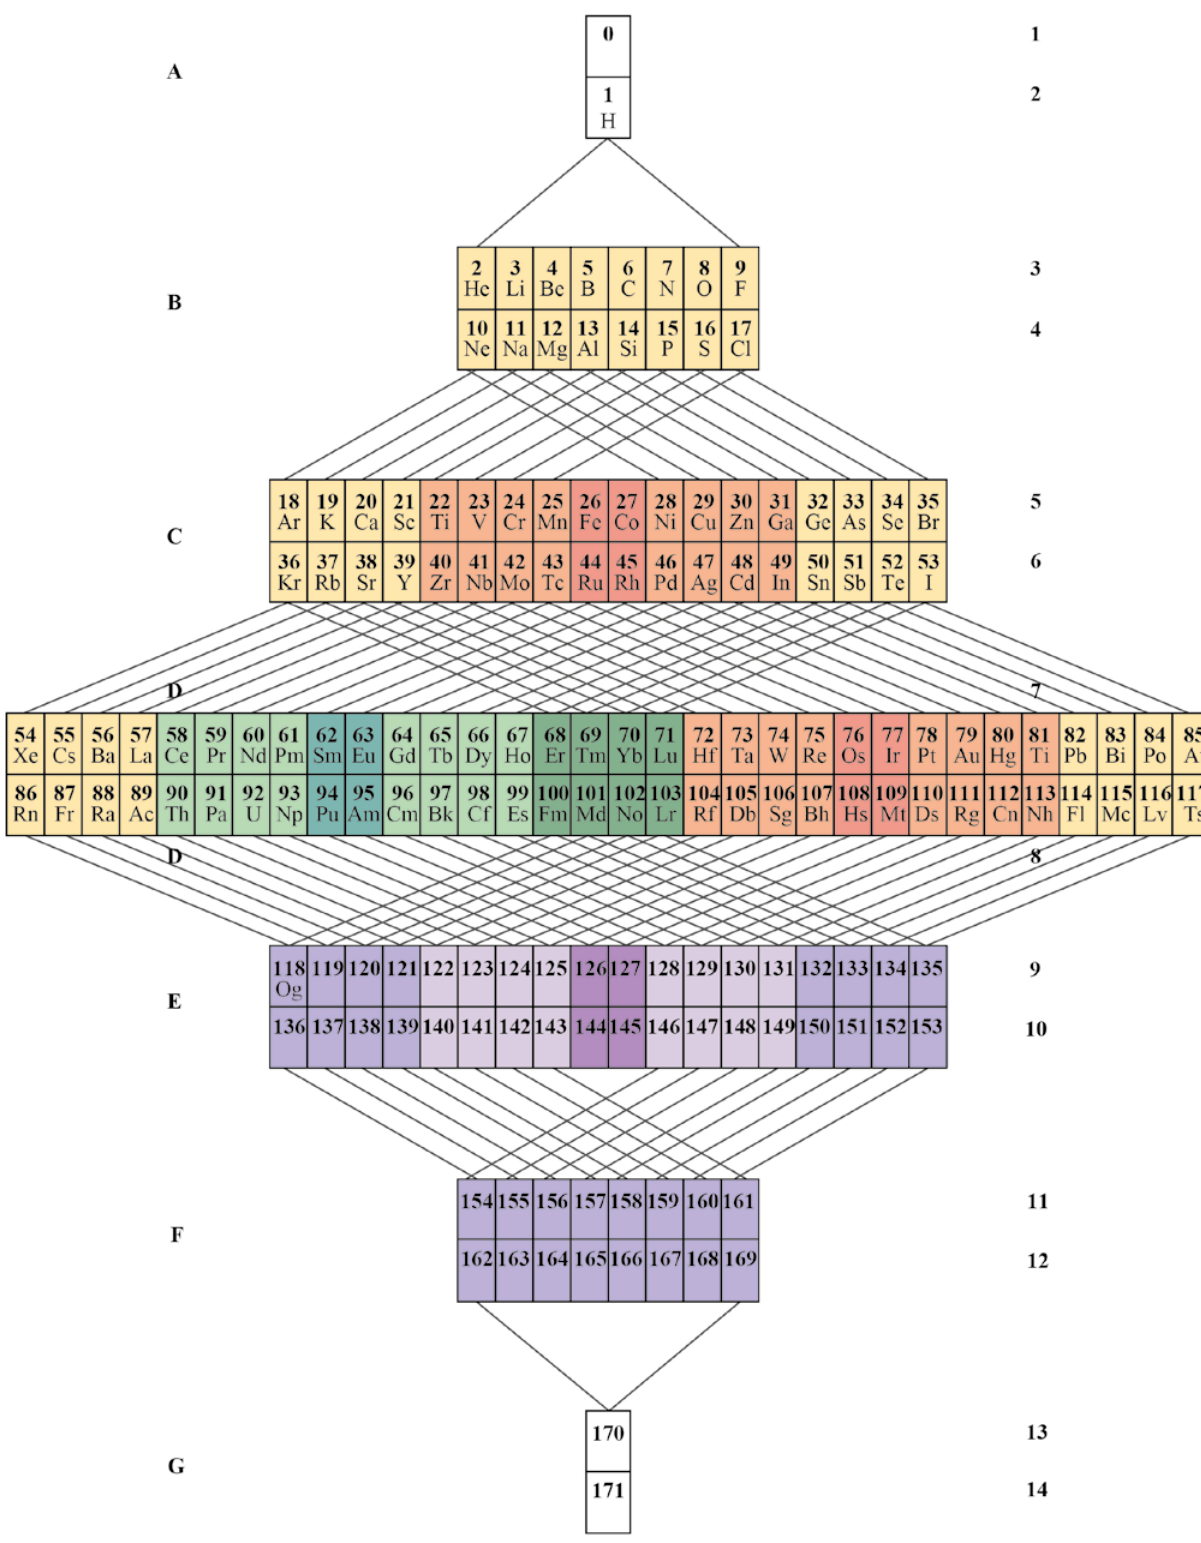
Figure 3. Periodic table based in triads, in the same color the elements that must present relations of